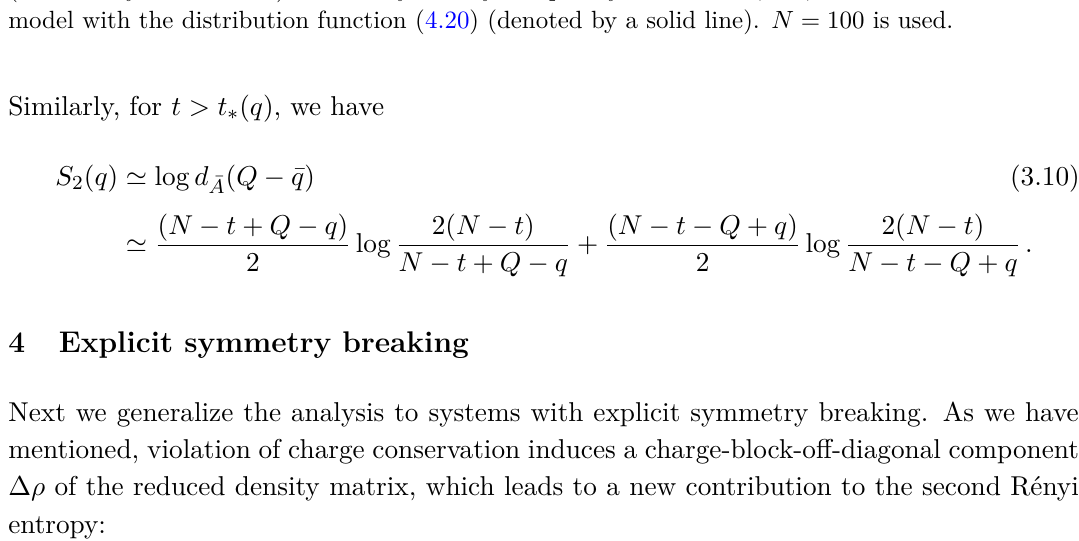
Figure 2 . Second Rényi entropy (3.8) for the symmetry preserving case with different values of Q (denoted by dotted lines) and the symmetry completely broken case, i.e., the limit σ → ∞ of the model with the distribution function (4.20) (denoted by a solid line). N = 100 is